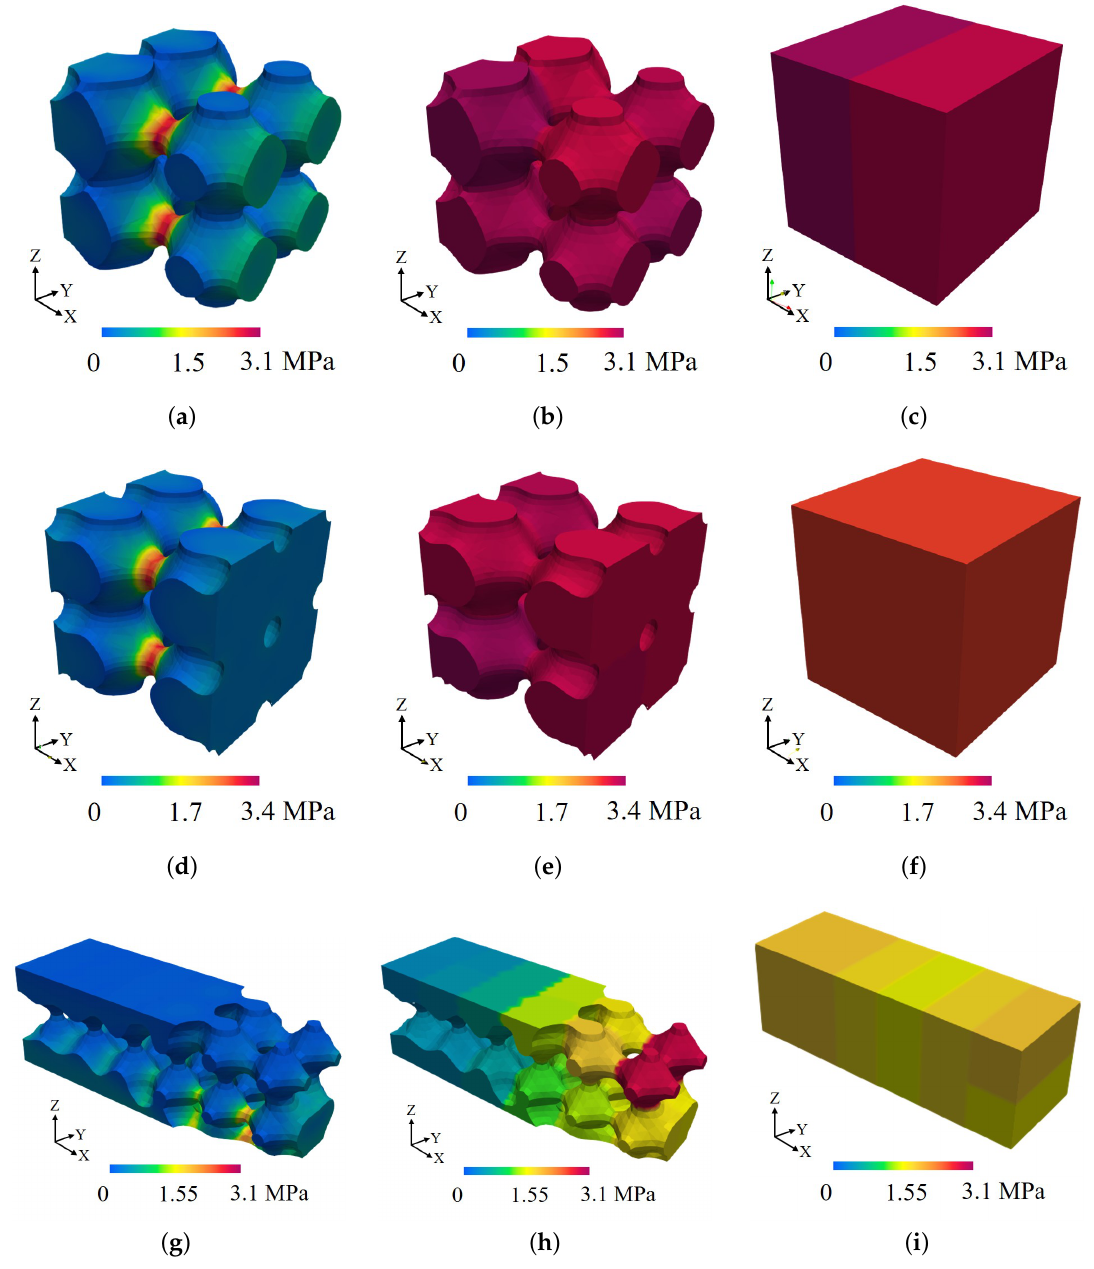
Figure 10. Comparison of the maximum von Mises stress in direct FEA (lattice) and our methodology in Schwarz primitive structures of graded density. Domains of 8 and 24 cells. Distribution of von Mises stress in lattice domain with ( a ) density per Equation (9); ( d ) density per Equation (10); and ( g ) density as in [7]. Maximum von Mises stress per cell in lattice domain with ( b ) density per Equation (9); ( e ) density per Equation (10); and ( h ) density as in [7]. Maximum von Mises stress per cell in homogeneous domain with ( c ) density per Equation (9); ( f ) density per Equation (10); and ( i ) density as in [7]. Detailed results in Table